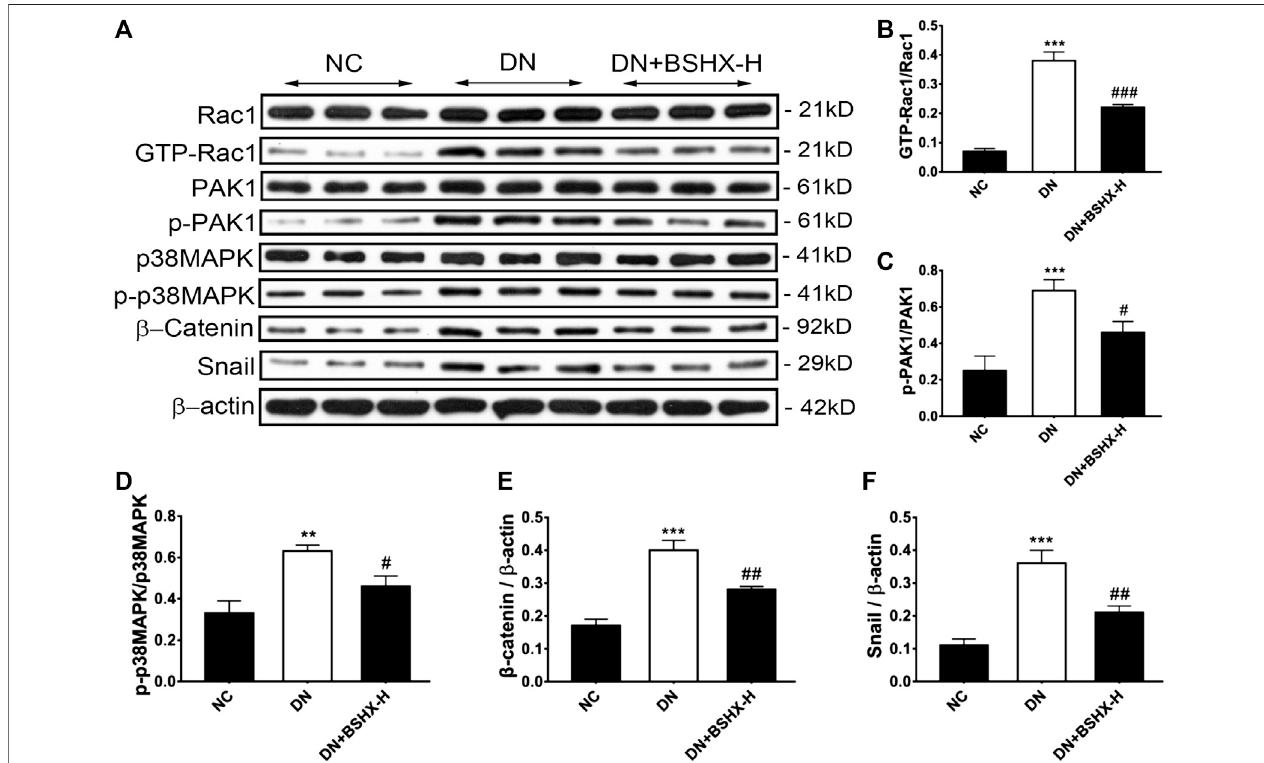
FIGURE7 | Effect of BSHX decoction on expression ofRac1/PAK1/p38MAPK signaling pathway proteins DN mouse kidney. (A) Representativewestern blots for Rac1, GTP-Rac1, PAK1, p-PAK1, p38MAPK, β -Catenin, and Snail protein expression in kidney tissue. β -actin was included as a loading control. (B) Quantitative analysis of GTP-Rac1/Rac1. (C) Quantitative analysis of p-PAK1/PAK1. (D) Quantitative analysis of p-p38MAPK/p38MAPK. (E) Quantitative analysis of Snail/ β -actin. (F) Quantitative analysis of β -Catenin/ β -actin. Band intensities were quanti fi ed by using Quantity One software. n (cid:1) 5 mice per group. All data are expressed as means ± SEM. * p < 0.05, ** p < 0.01, *** p < 0.001 vs. the NC group; # p < 0.05, ## p < 0.05, ### p < 0.001 vs. the DN model group.